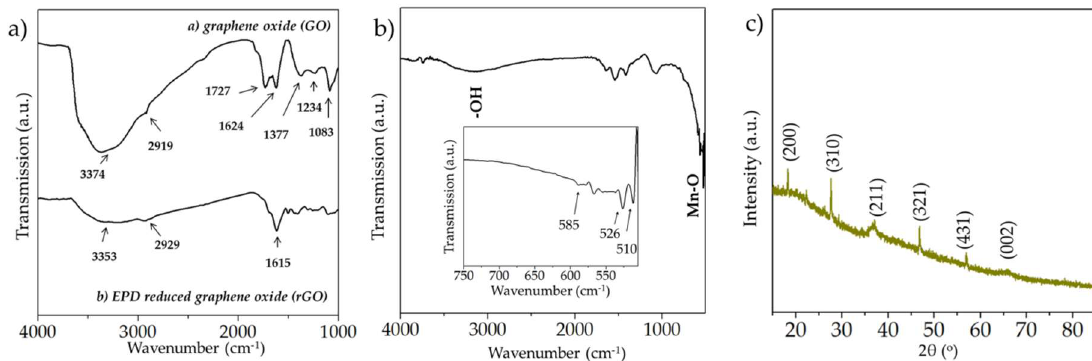
Figure 2. ( a ) FTIR spectra of the starting graphene oxide powders and the EPD reduced graphene oxide films; ( b ) FTIR spectrum and ( c ) the X-ray diffraction (XRD) pattern of the electrochemically deposited MnO x films.